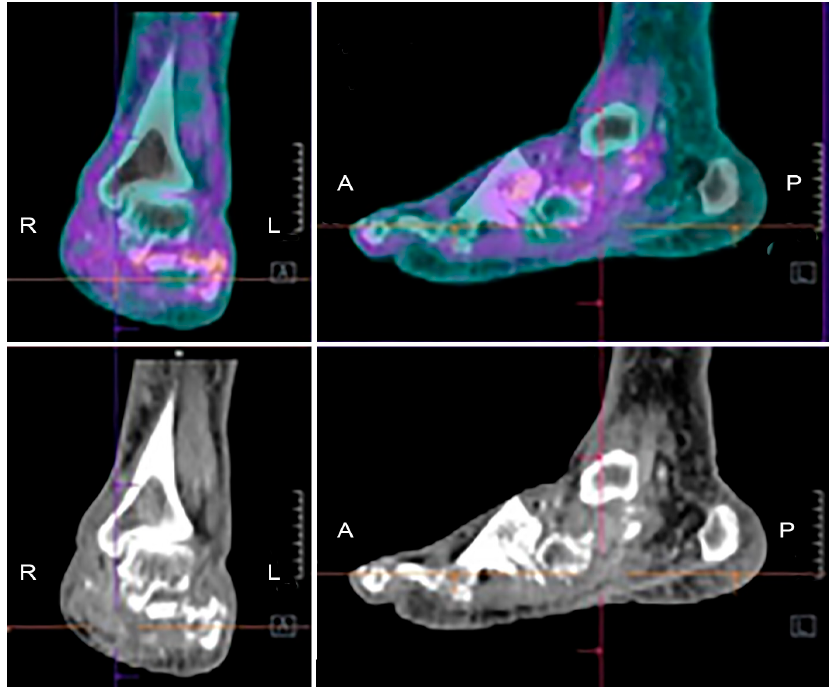
Figure 5. Example of [ 18 F]FDG PET/CT in a patient with Charcot osteoarthropathy. Fused images (upper panels) show moderate and diffuse uptake, which is interesting in particular bones and joints of the mid and hind-foot. Co-registered low-dose CT images (lower panels) show the evident destruction of bony architecture. These findings are consistent with the diagnosis of Charcot foot, but they do not allow discriminating a pan-inflammation from a possible superimposed infection.